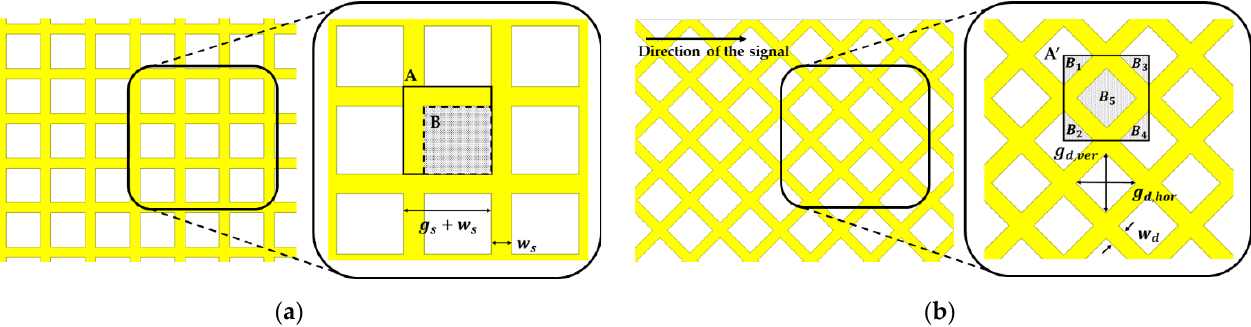
Figure 1. Structure of the mesh pattern for schematic representation and OT: ( a ) square mesh; ( b ) diamond mesh.